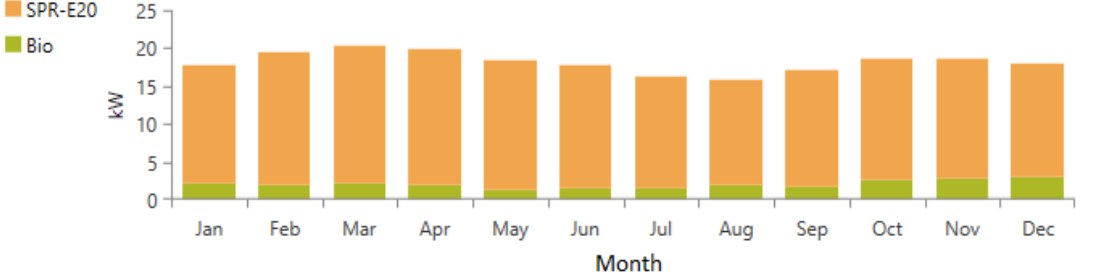
Figure 12. Monthly average electrical output from the optimal configuration system.